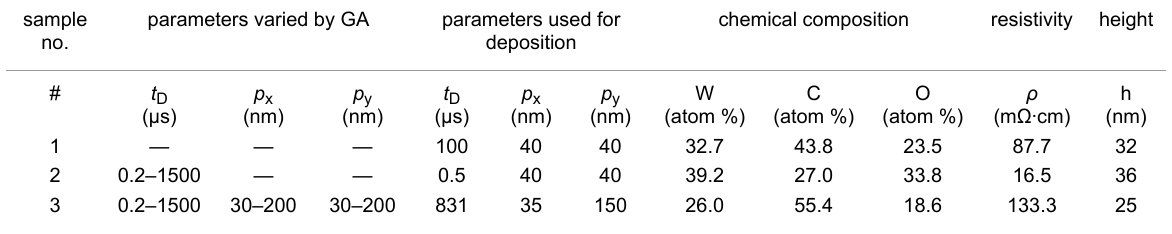
Table 1: Summary of parameters used for deposition of samples 1 (reference), 2 (GA-optimization for highest conductance) and 3 (GA-optimization for lowest conductance). The reference sample was deposited with fixed values for dwell-time and pitch whereas the dwell-time for sample 2 was varied by the GA in the range of t D = 0.2–1500 μ s at fixed pitch of p x = p y = 40 nm. For sample 3, dwell-time and pitch were both allowed to vary in the range of t D = 0.2–1500 μ s and p x , p y = 30–200 nm. The GA-optimization was performed for 6 optimization cycles, each comprising 8 parameter sets, which were deposited between Cr/Au electrodes by using a dose of 3 nC/ μ m 2 per parameter set. The parameters obtained from the in situ experi- mental GA analysis were used to deposit another set of samples with a dose of 27 nC/ μ m 2 and A = 3 × 7 μ m 2 , which were analyzed by means of AFM and electrical I ( V )-measurements to obtain the resistivity of the samples. The chemical composition was determined by EDX-measurements that were performed on separate 2 × 2 μ m 2 samples in order to prevent changing the conductivity of the samples with respect to further electrical measurements. All other deposition parameters were kept fixed: U = 5 kV, I nominal = 6.3 nA. sample